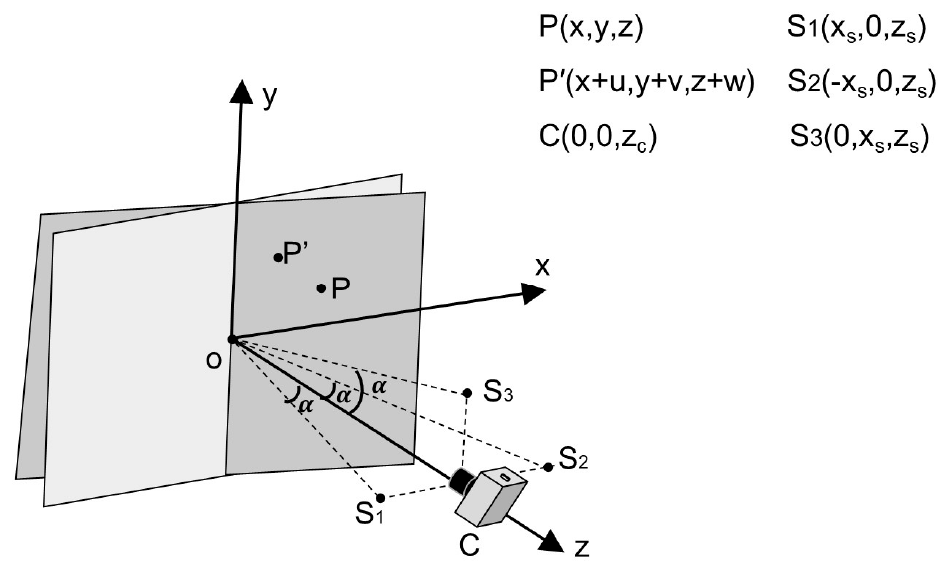
Figure 2. Geometric model of optical setups for measuring geometric motions of the rigid body by DPSI.